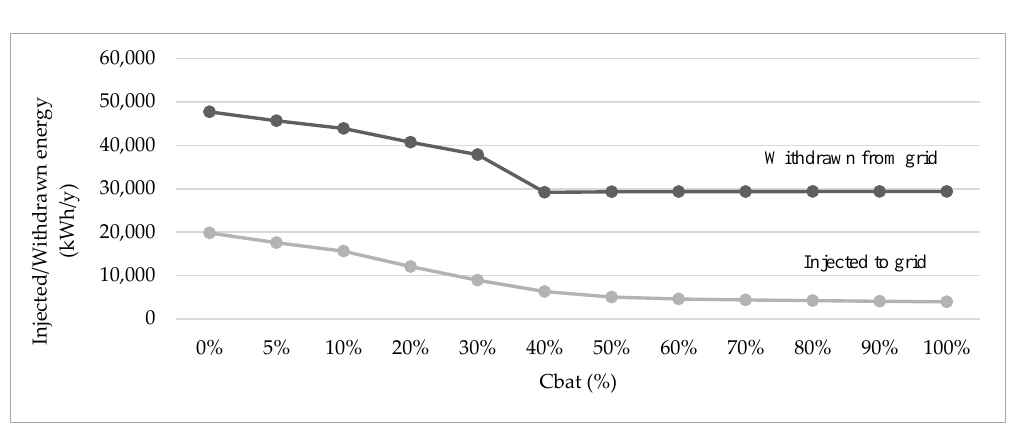
Figure 9. Comparison between various storage capacity and the injected and withdrawn energy from the grid ( MC1 ).